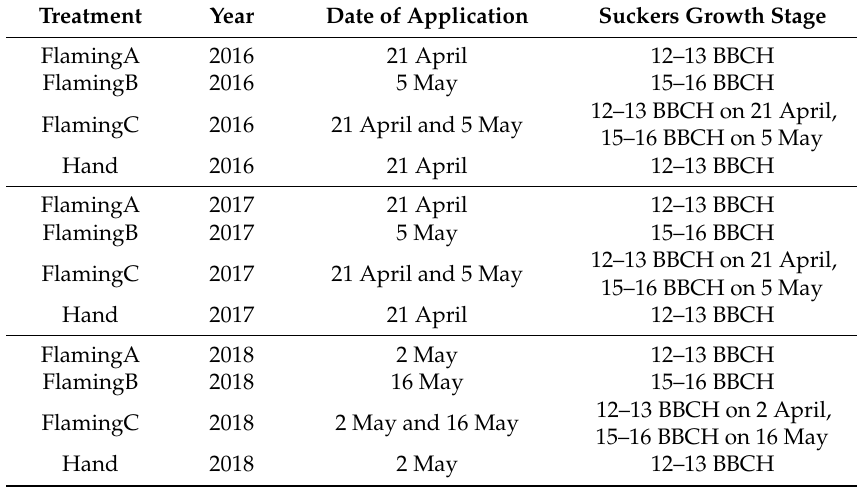
Table 1. Date of suckering treatments, and the growth stage of the most developed suckers at the time of